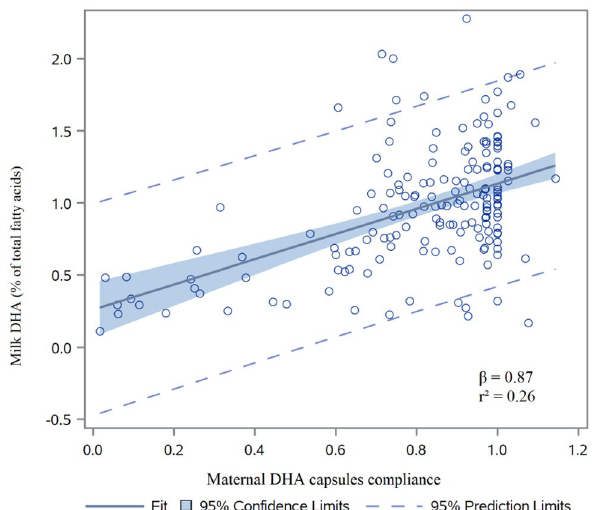
Figure 2. Milk DHA content in function of the maternal compliance in mothers who received DHA capsules. Compliance corresponds to the ratio of capsules taken over expected from randomization until day 14 ± 2 after delivery. DHA docosahexaenoic